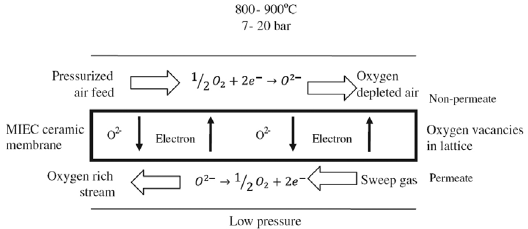
Figure 1. Schematic representation of O MIEC membranes 7 .